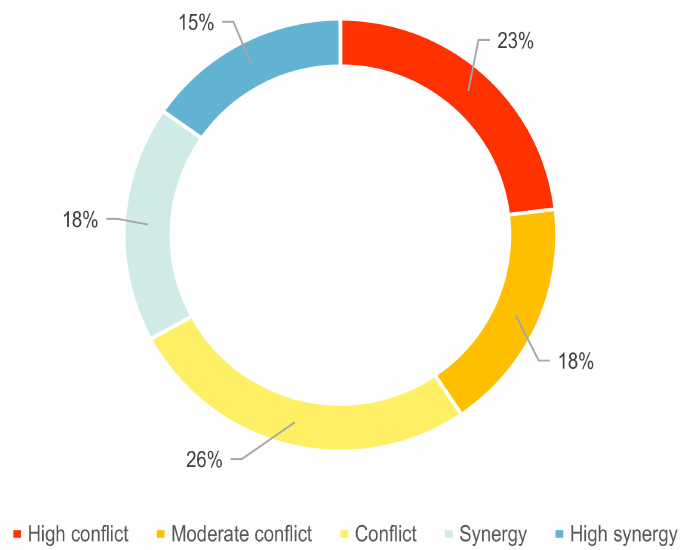
Figure 9. Distribution of Conflict and Synergies in the Conservation Zones of the Environmental Regulation